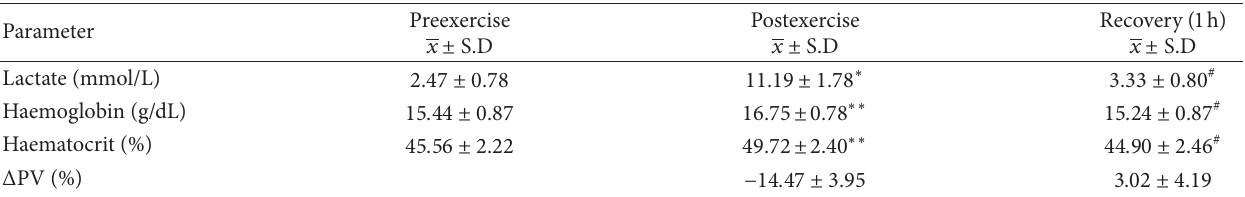
Table 1: Effect of physical exercise on lactate, haemoglobin concentration as well as haematocrit, and delta plasma volume ( Δ PV) before, after, and 1 hour after exercise.